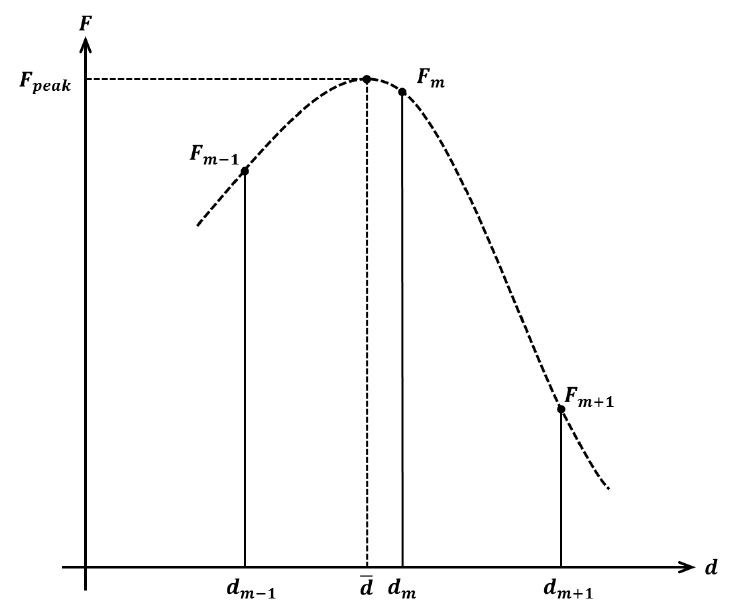
Figure 5. Gaussian